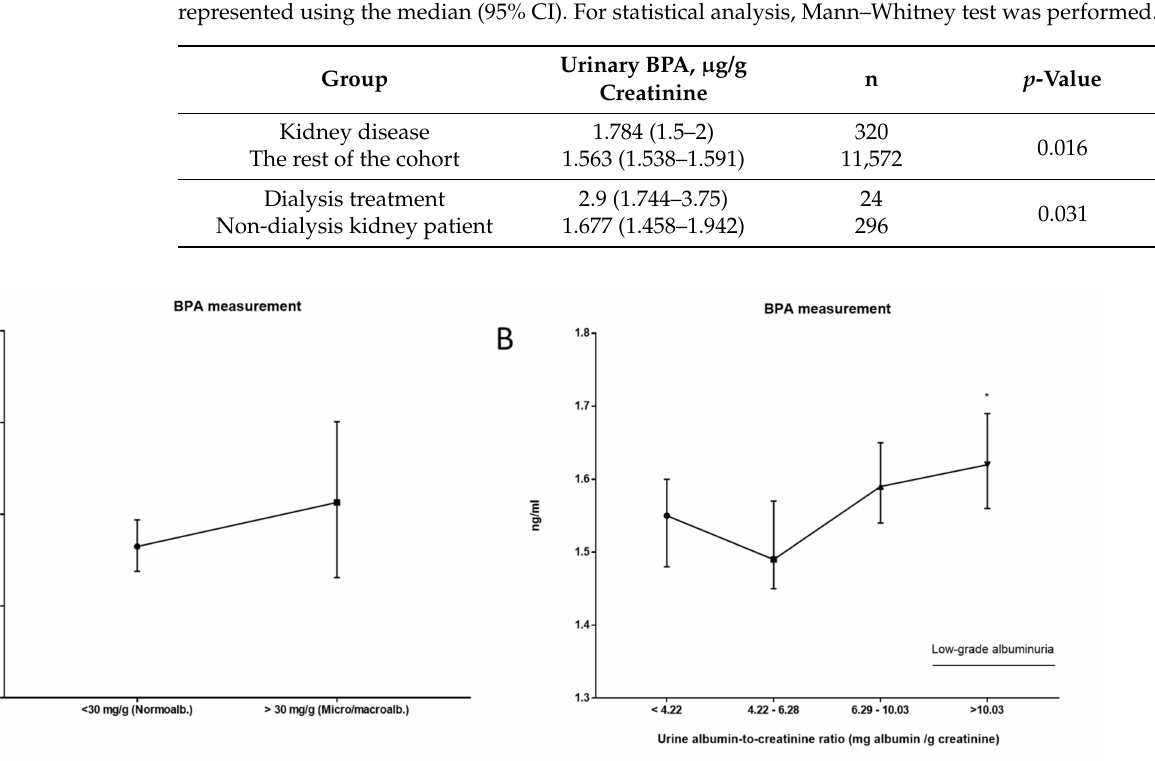
Figure 10. Schematic representation of the results obtained in the urinary BPA according to the urine albumin-to-creatinine ratio. ( A ) < 30 mg/mL (normoalbuminuria) vs. >30 mg/Dl (micro/macroalbuminuria). ( B ) Normoalbuminuria. The population was classified into four quartiles. Those in Q4 are considered to have low-grade albuminuria. All results were expressed as median (95% CI). Kruskal–Wallis test followed by Dunn ´ s multiple comparisons test was performed. * p -value <